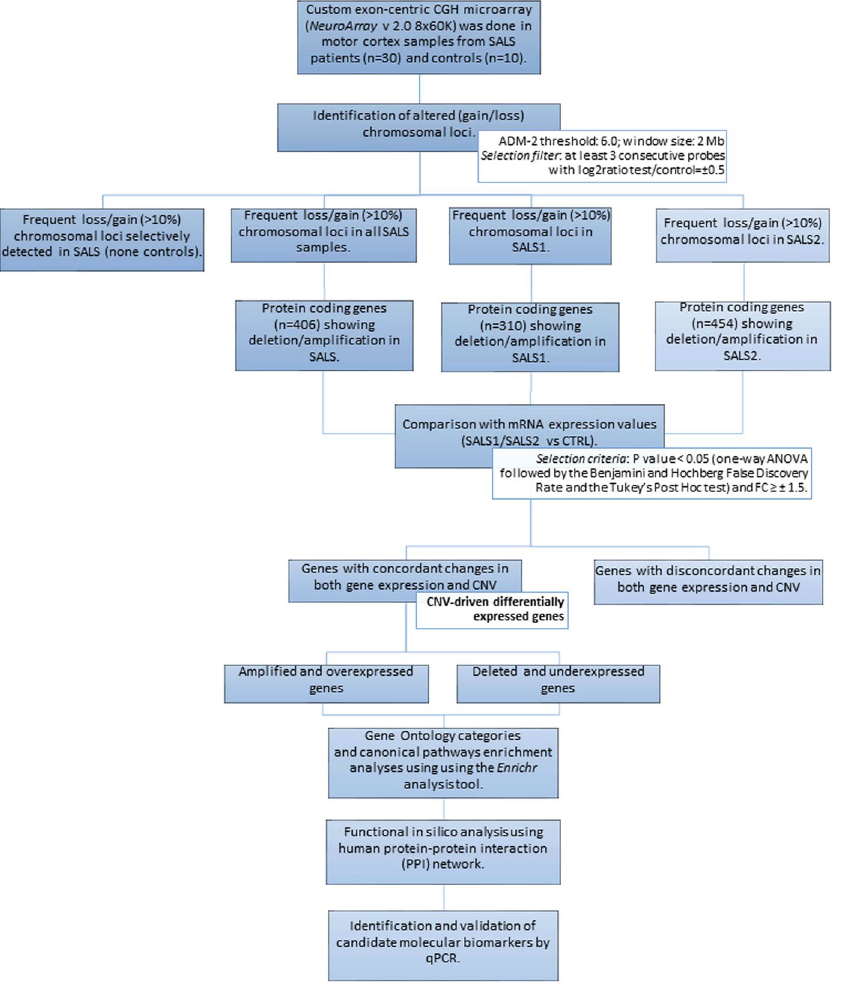
Figure 5. Experimental workflow of multi-omics analysis for characterization of CNV-driven differentially expressed genes in SALS patients. The workflow depicts the steps performed in this study, from data acquisition to the visualization, validation and export of results in various output formats. See Materials and Methods section for